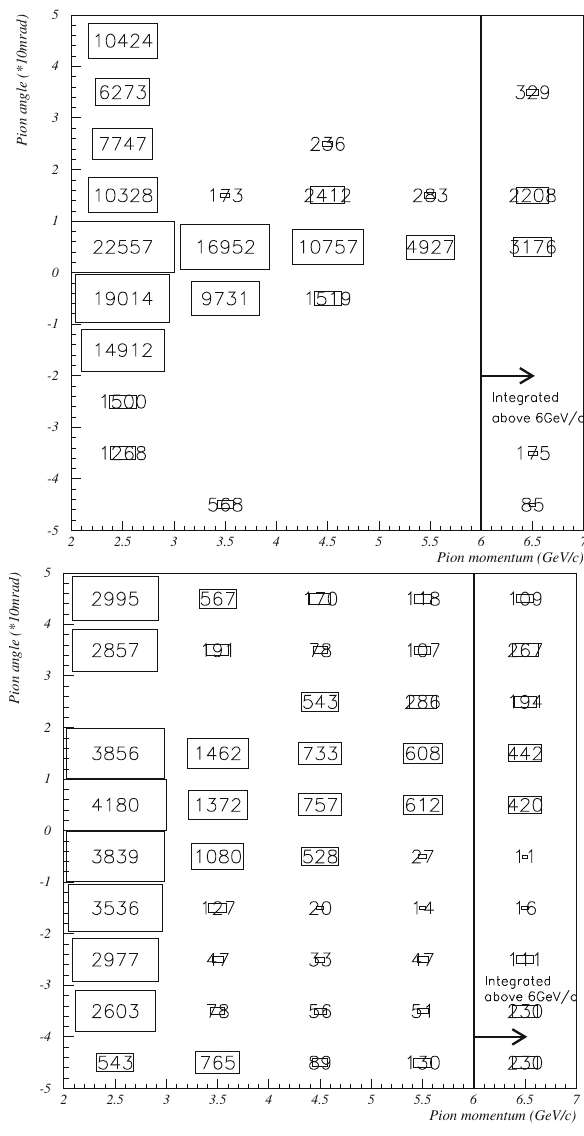
Fig. 18 The fit result of pion ( p π ,θ π ) distribution in November 1999 run. The top figure shows the resulting central value of the weighting parameters, and the bottom figure shows the estimated uncertainty on fromthefit.TheneutrinobeamdirectiontoSKfromthetargetisdefined as 0 ◦ ( θ π = 0). The above pion angular distribution (and energy distri- bution) is affected by the detector acceptance (PIMON acceptance for the Cherenkov photons from the pions by using the pie-shaped spheri- cal mirror in Fig. 16) that is not uniform over the angular distribution. It is the reason why the values in positive θ π is larger than ones in the negative θ π although they should be